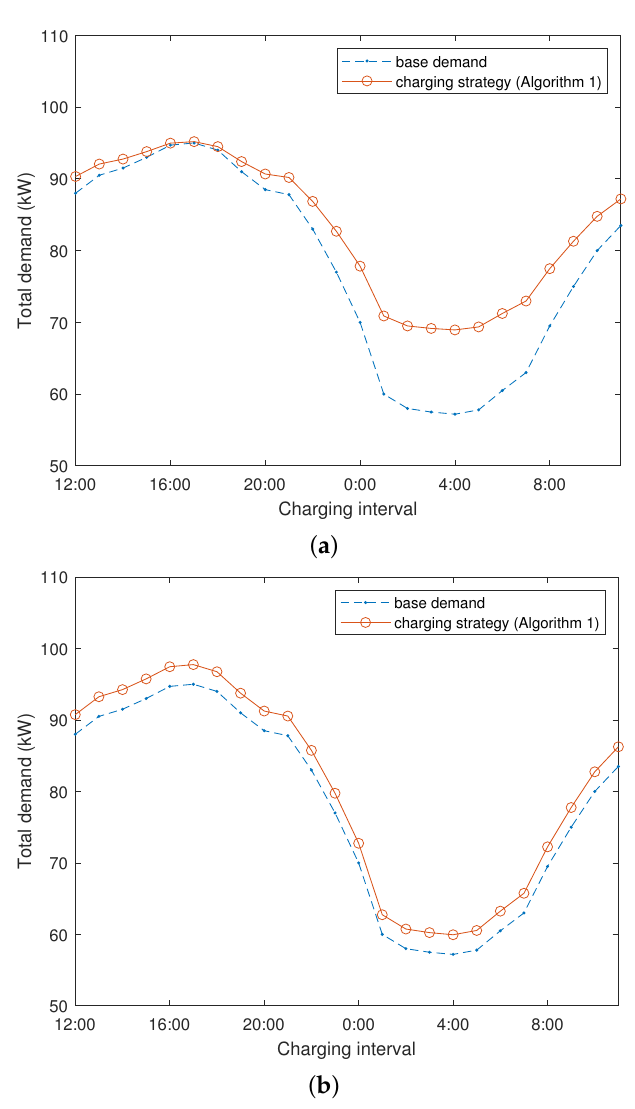
Figure 2. Aggregate demand for Algorithm 1. ( a ) Without replay attack; ( b ) under replay